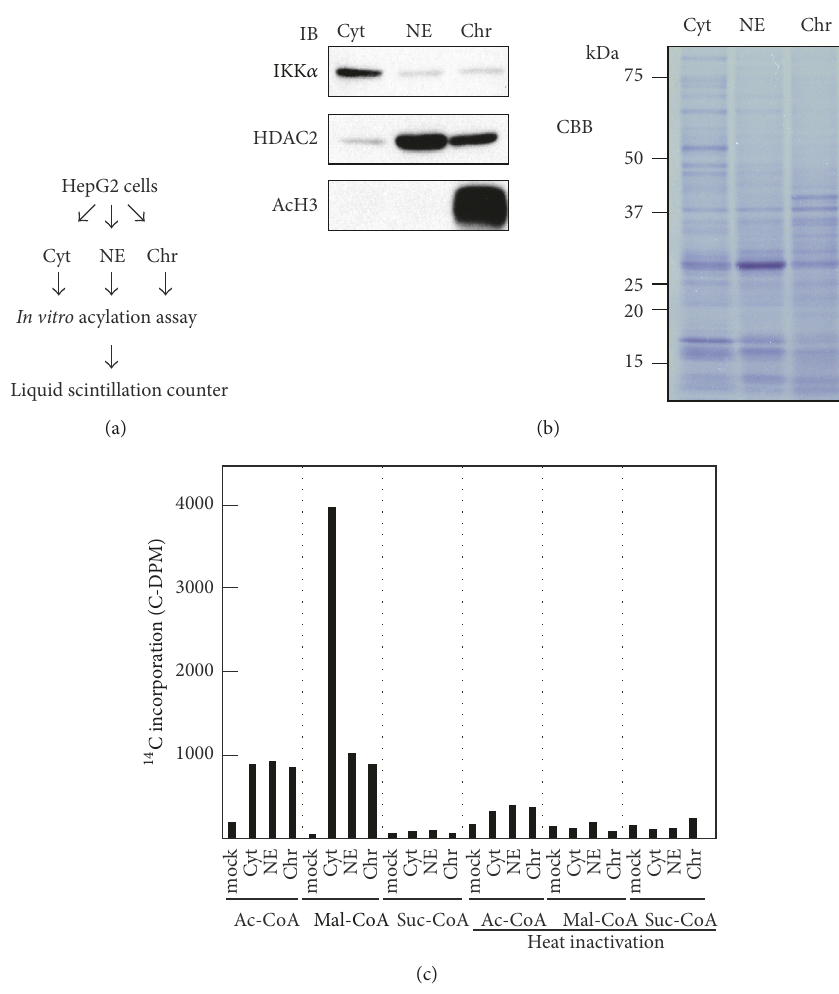
Figure 1: In vitro acylation assay using fractionated HepG2 cell extracts. (a) Schematic diagram of the fractionation of HepG2 cell extracts and in vitro acylation assay. (b) Validation of HepG2 cells fractionated into cytosolic, nuclear, and chromatin extracts. 4 𝜇 g of each extract was assessed by western blot (left panel). IKK 𝛼 , HDAC2, and AcH3 were used as cytosolic, nuclear, and chromatin fraction markers, respectively. CBB staining of loading proteins is shown in the right panel. Cyt: cytosolic extracts; NEs: nuclear extracts; Chr: chromatin extracts. (c) In vitro acylation assays using fractionated cell extracts. 14 C-labeled coenzyme A incorporation was assessed by liquid scintillation counting. Reaction mixtures without cell extracts were used as negative controls (mock). To show that the incorporation was an enzymatic reaction, cell extracts were heat-inactivated at 96 ∘ C for 10min. Ac-CoA: acetyl-coenzyme A; Mal-CoA: malonyl-coenzyme A; Suc-CoA: succinyl-coenzyme